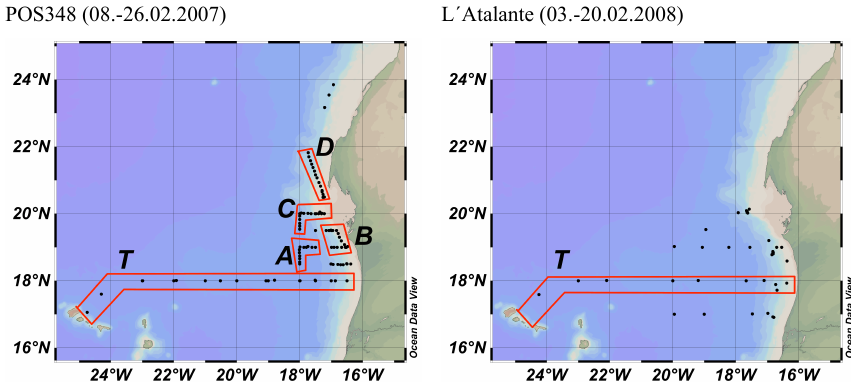
Fig. 1. Sampling positions (black dots) during POS 348 (2007, left) and L’Atalante (2008, right). The labels A to D indicate the four days with high sample resolution during the POS 348 cruise. Each label indicates one day of sampling: A: 20 February 2007, B: 21 February 2007, C: 22 February 2007, and D: 23 February 2007. The label T indicates the transect along 18 ◦ N (Schlitzer,